Question: What visual encoding does this figure use to show its data?
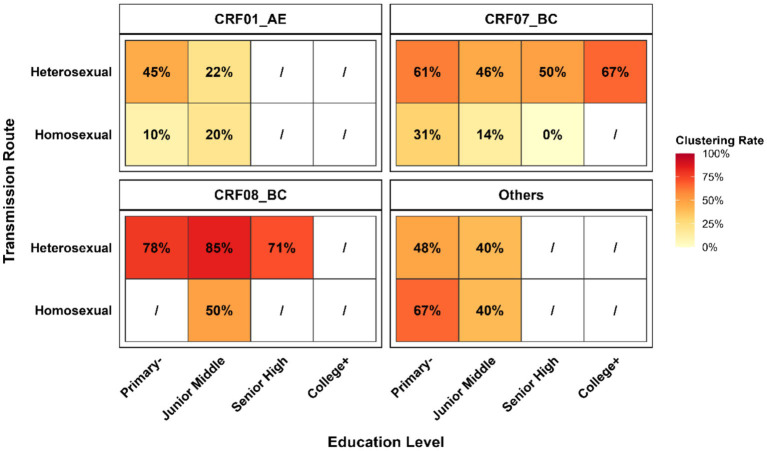
Answer: heatmap